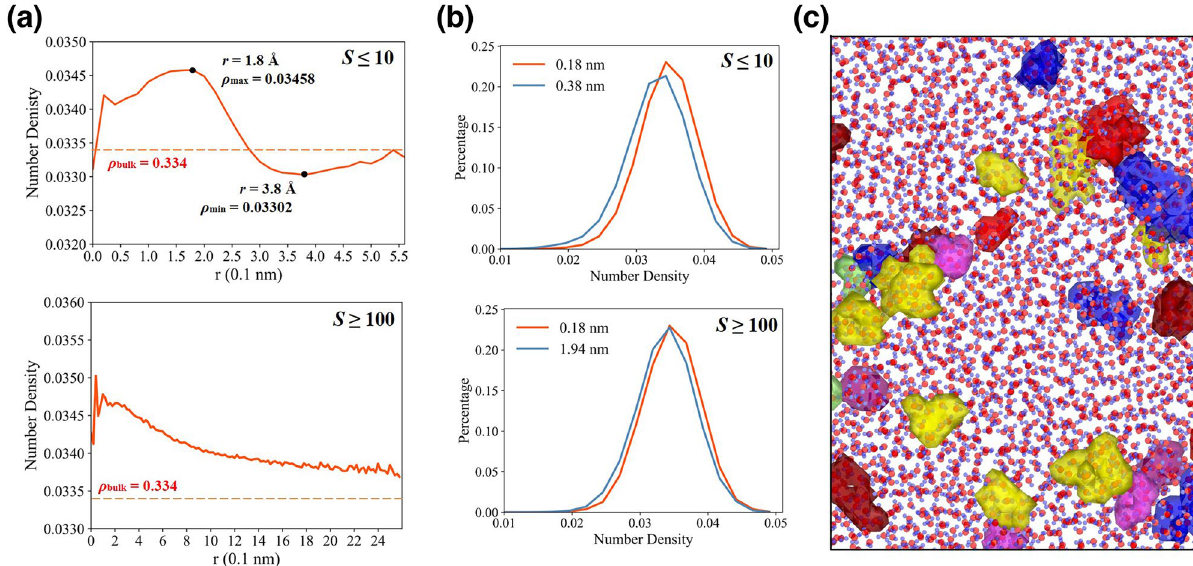
Figure 6. High- and low-density patches around the geometrical center of clusters at 278 K. ( a ) The number density around the geometrical center of clusters with S ≤ 10 and S ≥ 100, which denotes molecular number. The number density is calculated as the number of oxygen atoms inside a probe sphere located at certain oxygen atoms in the clusters with a radius of 4.6 Å. ( b ) The distributions of number density located at maximum density and minimum density. ( c ) Snapshots of several clusters selected in local region drawn by Ovito 58